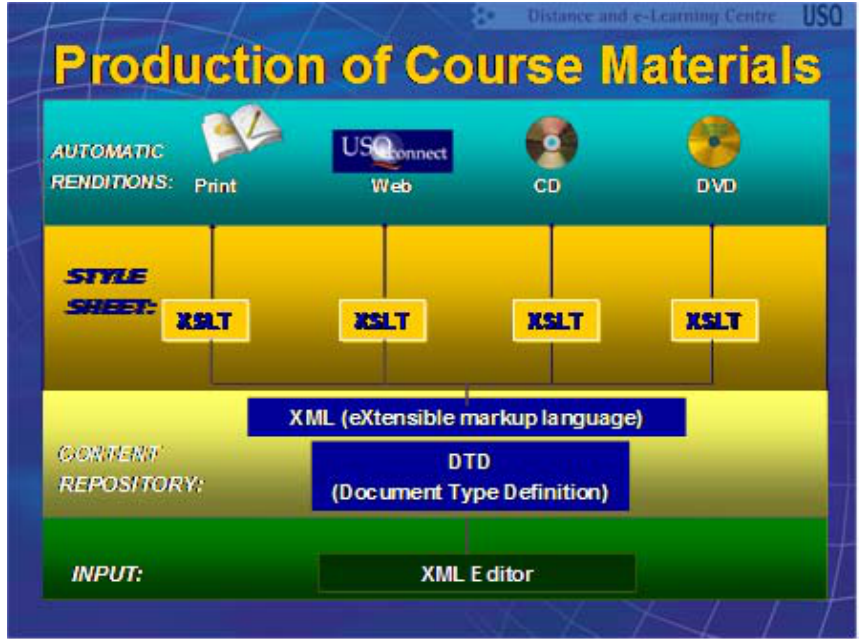
Figure 4. GOOD System Course Materials Production